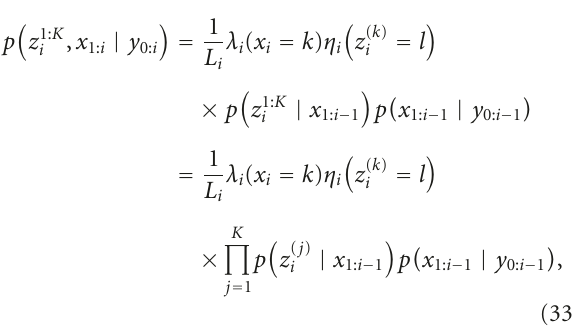
δ i − 1 = p ( x i − 1 = j ), and the relative significance of i − 2th path is δ i − 2 = p ( x i − 1 / = j ) p ( x i − 2 = j ), and so on (we omit